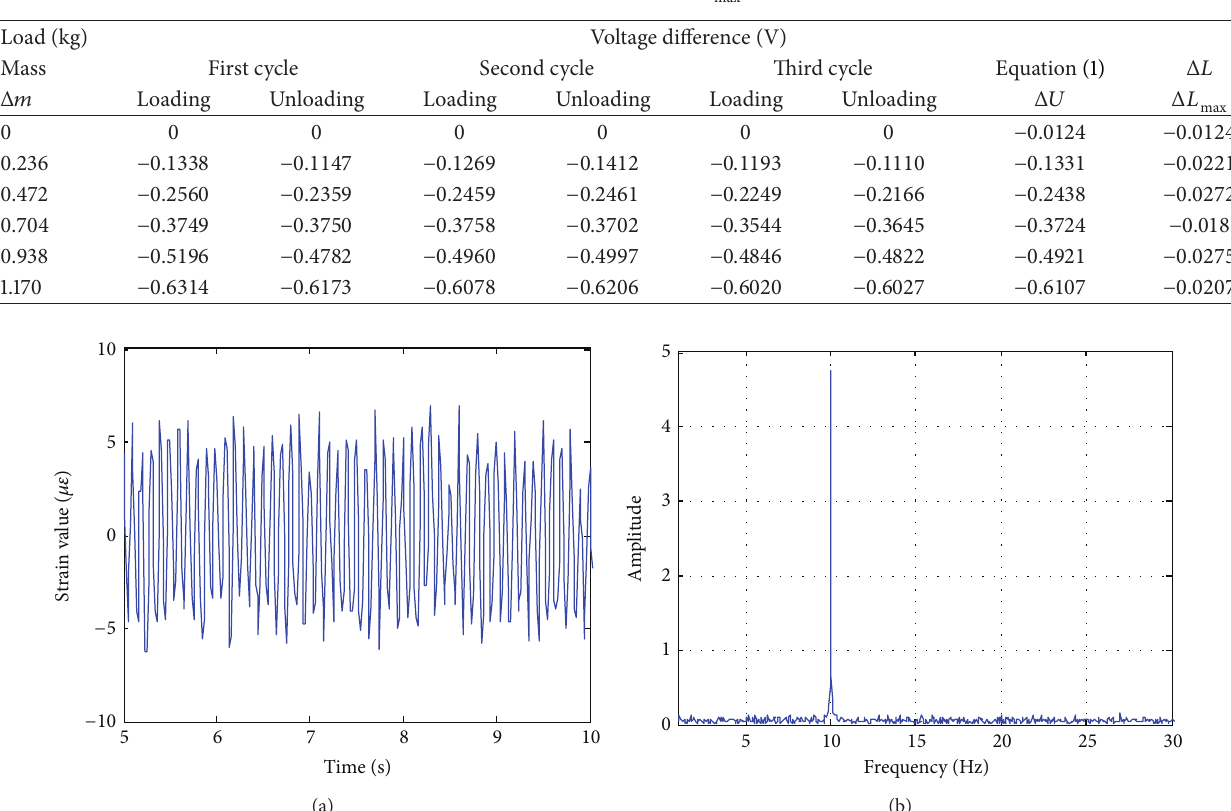
Table 3: The value of Δ𝐿 max .